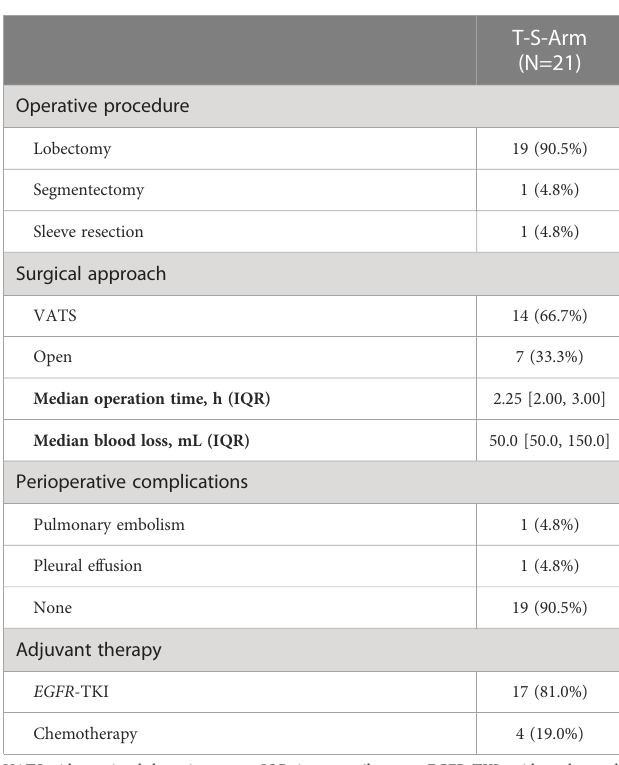
TABLE 3 Surgical information and adjuvant therapy of patients in T-S-Arm.